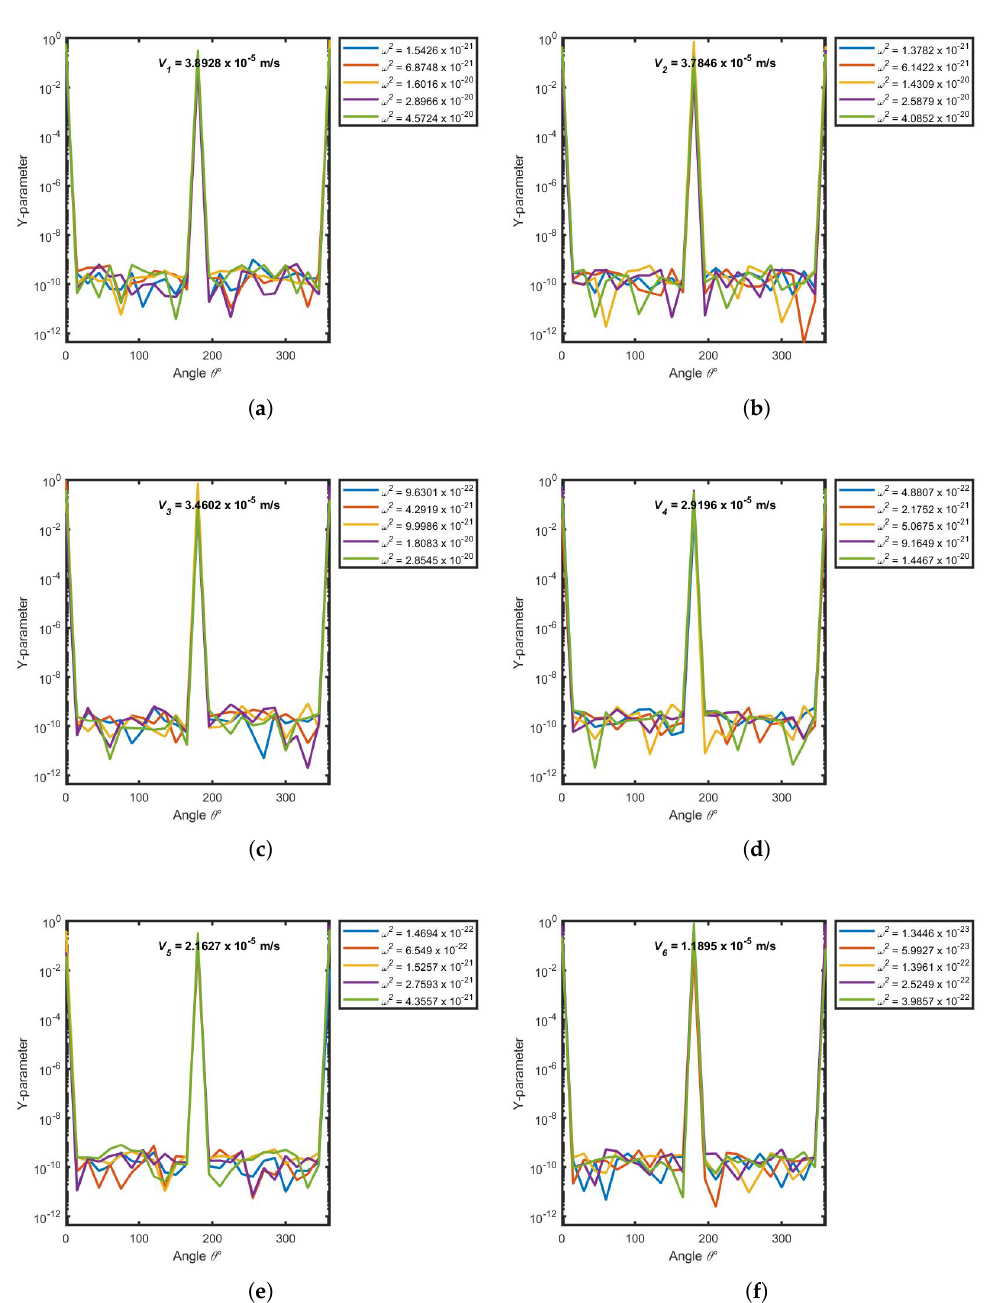
Figure 6. ( a – f ). Y- parameter as a function of angle ( θ ) at a thickness of h = 1.7 × 10 − 5 m, time (cid:0) (cid:1) t = 10 d and varying separation constant ω 2 . For each channel thickness shown in Figure 3, eleven (11) symmetric velocity data points are generated, and each data point used in the computation of (cid:0) (cid:1) Y p Y-parameter profiles. Due to the symmetric nature of the velocity profiles, only half-wing of the plane; consisting of six (6) data points, is presented here. The data for the other half-wing is presented in Appendix